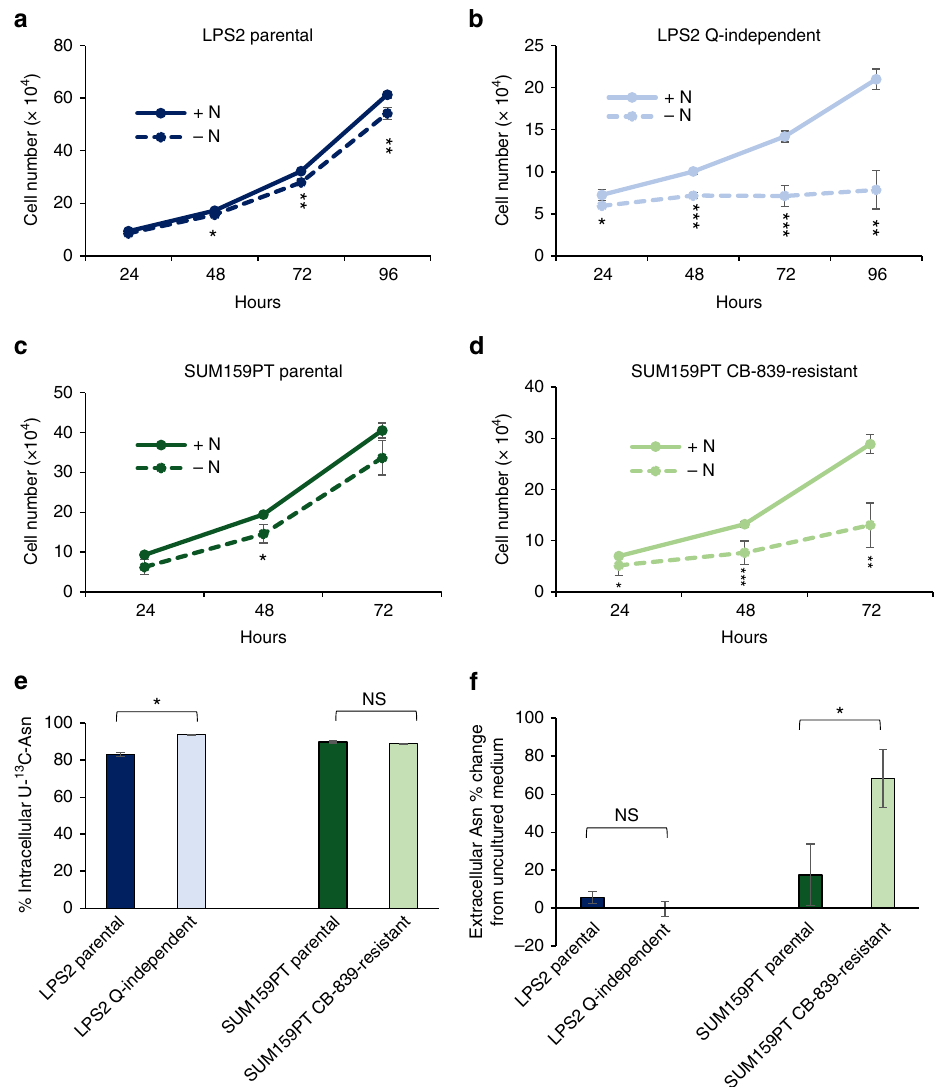
Figure 1 | Resistance to glutamine withdrawal or glutaminase inhibition causes cellular asparagine dependence. ( a – d ) Proliferation curves of LPS2 parental, LPS2 glutamine (Q)-independent, SUM159PT parental and SUM159PT CB-839-resistant cells in the presence or absence of 0.1mM asparagine (N) in the medium. ( e ) Percentages of intracellular 13 C-labelled asparagine in LPS2 parental and glutamine-independent, as well as SUM159PT parental and CB-839-resistant cells labelled with U- 13 C-asparagine in the medium for 24h, as determined by LC-MS. ( f ) The per cent change in medium asparagine levels as determined by LC-MS after 24-h incubation time for the indicated cells or for medium in an empty tissue culture plate (blank). Error bars denote s.d. of the mean ( n ¼ 3). P values were calculated by the Student’s t-test: * P o 0.05; ** P o 0.01; *** P o 0.001; NS, not significant. NATURE COMMUNICATIONS|7:11457|DOI: